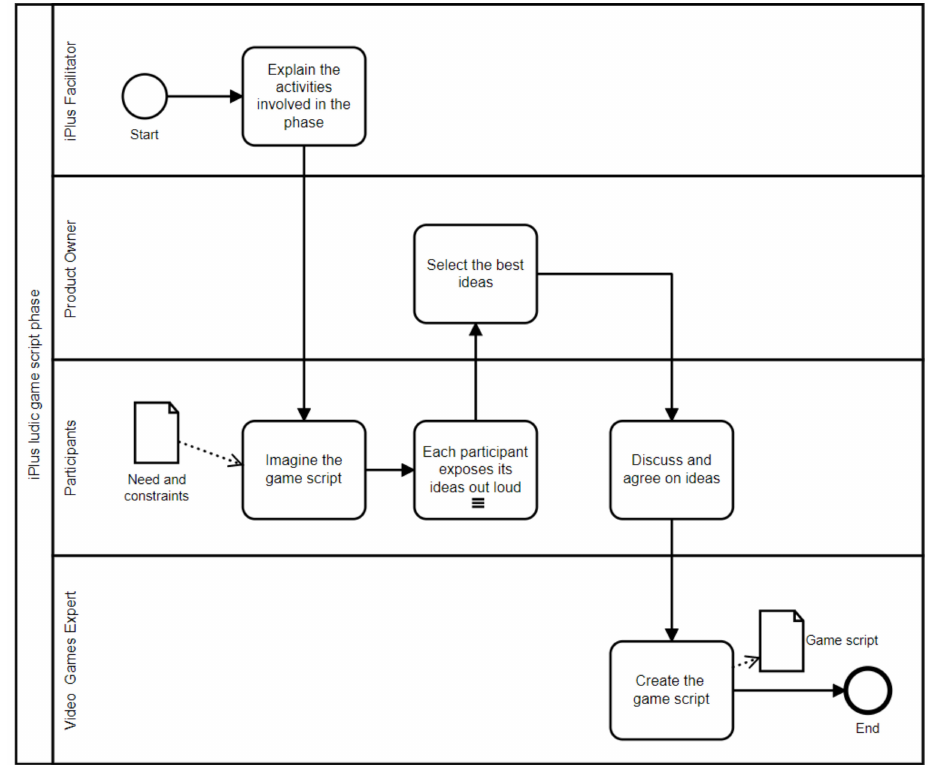
Figure 6. Ludic Game Script Phase